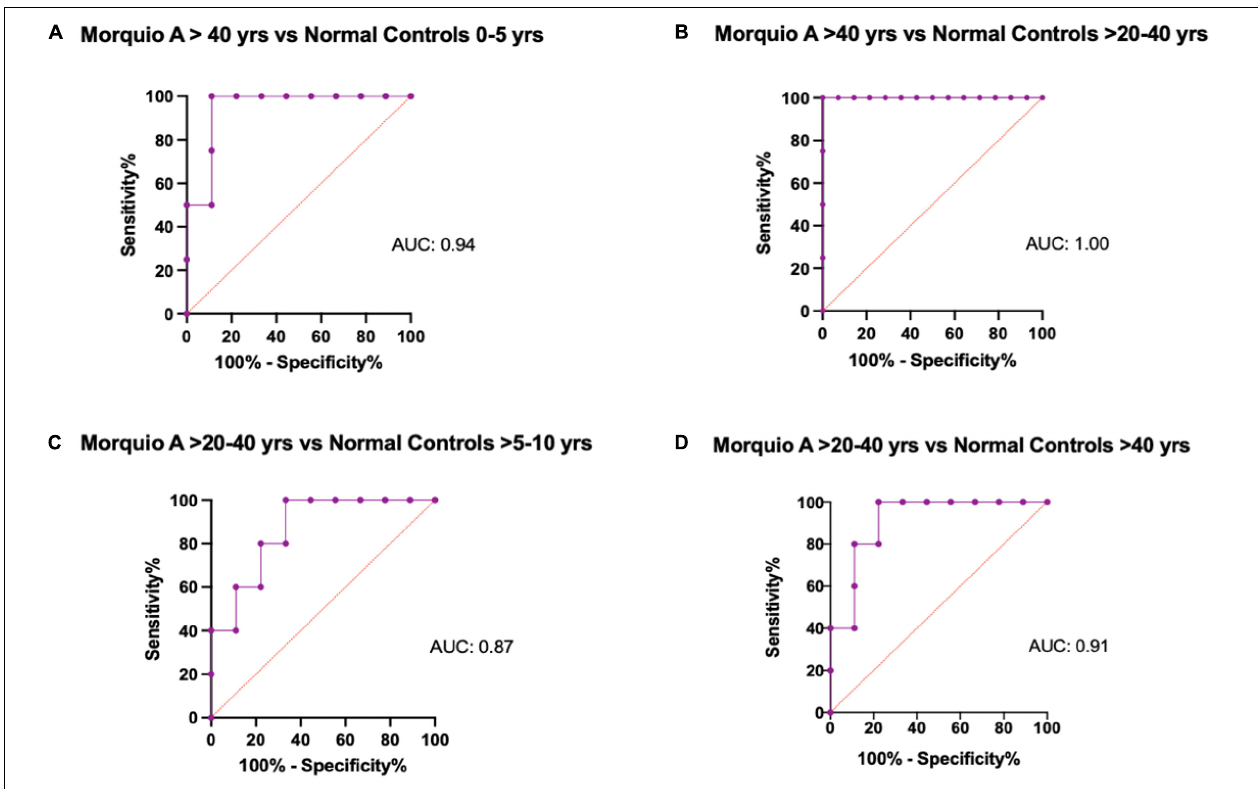
FIGURE 4 | Representative figures of receiver operating characteristic (ROC) curves for Elastin comparing different age groups. Comparison of the diagnostic ability of Elastin in the Morquio A cohort and the normal cohort stratified by age. (A) Morquio A patients > 40 years of age vs. Normal controls 0 to 5 years of age, (B) Morquio A patients > 40 years of age vs. Normal controls > 20 to 40 years of age, (C) Morquio A patients > 20 to 40 years of age vs. Normal controls 5 to 10 years of age, (D) Morquio A patients > 20 to 40 years of age vs. Normal controls > 40 years of age. AUC, Area under the